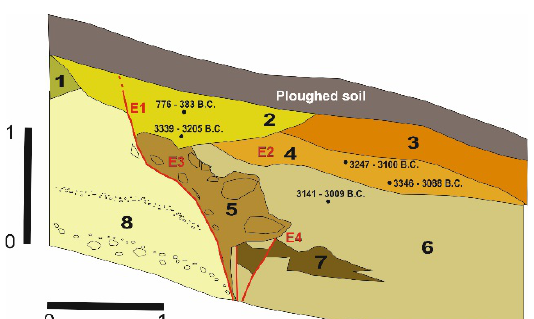
Fig. 6: Trench B. View and simplified log of the E trench wall. Black dots indicate dated radiocarbon samples. Stratigraphic units and deformation zones are described in the